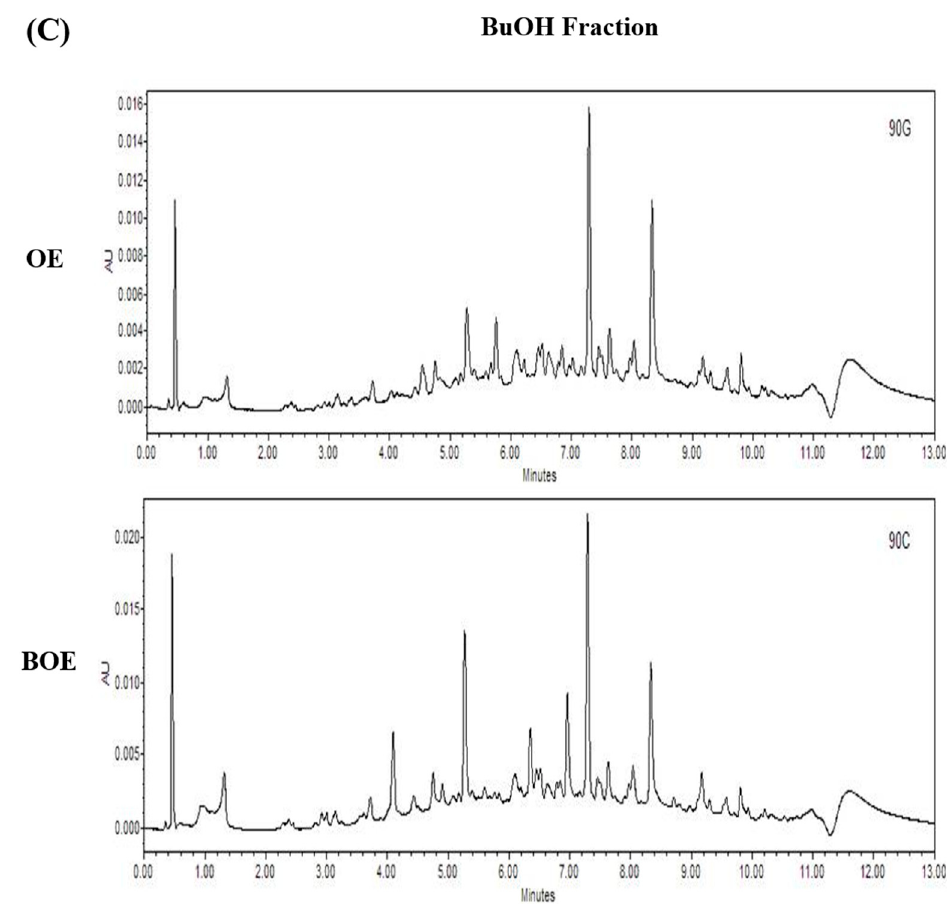
Figure 5. Comparison of UPLC chromatogram of O. japonicus extracts (OE) and bioconverted O. japonicus extracts (BOE). The UPLC results of hexane fraction ( A ), Ethyl acetate (EtOAc) fraction ( B ), and Butanol (BuOH) fraction ( C ) are shown.